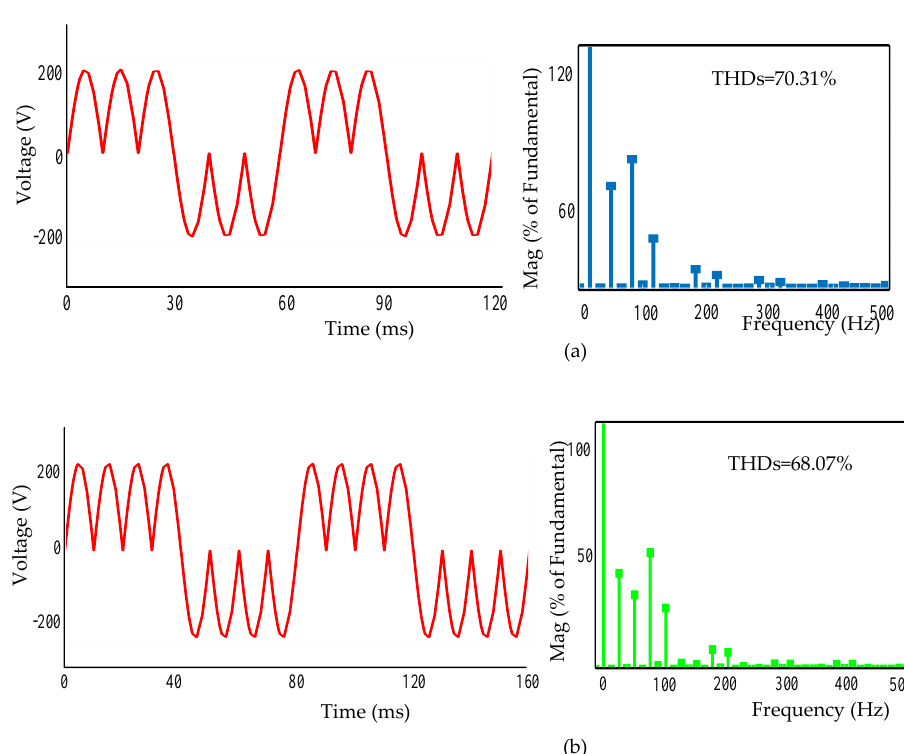
Figure 2. Output voltage with THDs of conventional single-phase to single phase step down cycloconverters ( a ) one − third and ( b ) one − fourth frequency conversion of 50 Hz.